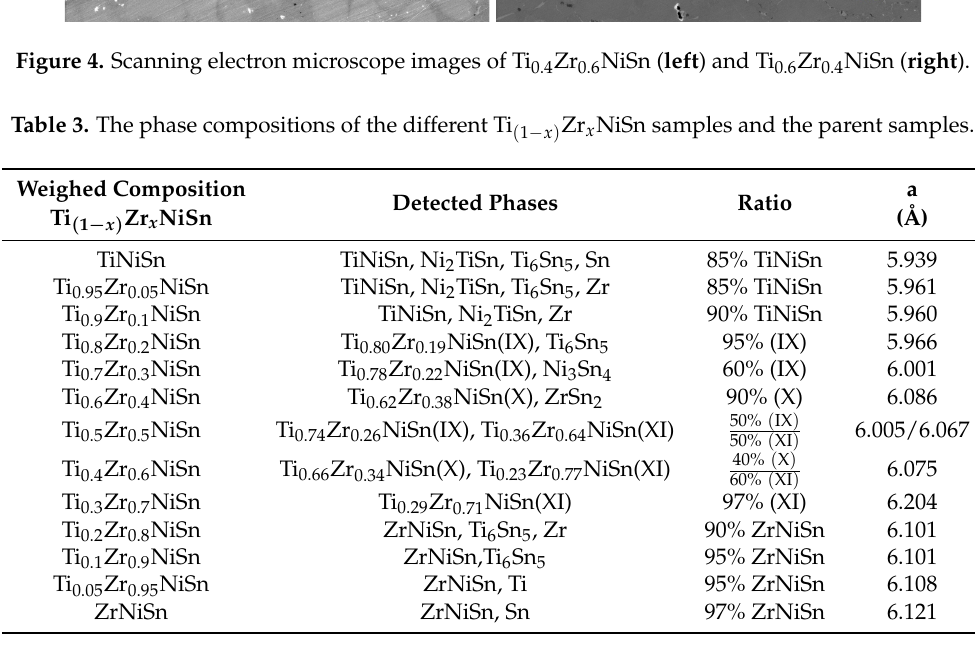
Table 4. Compositions of the stable Heusler phases with an error range of 3%. Stable